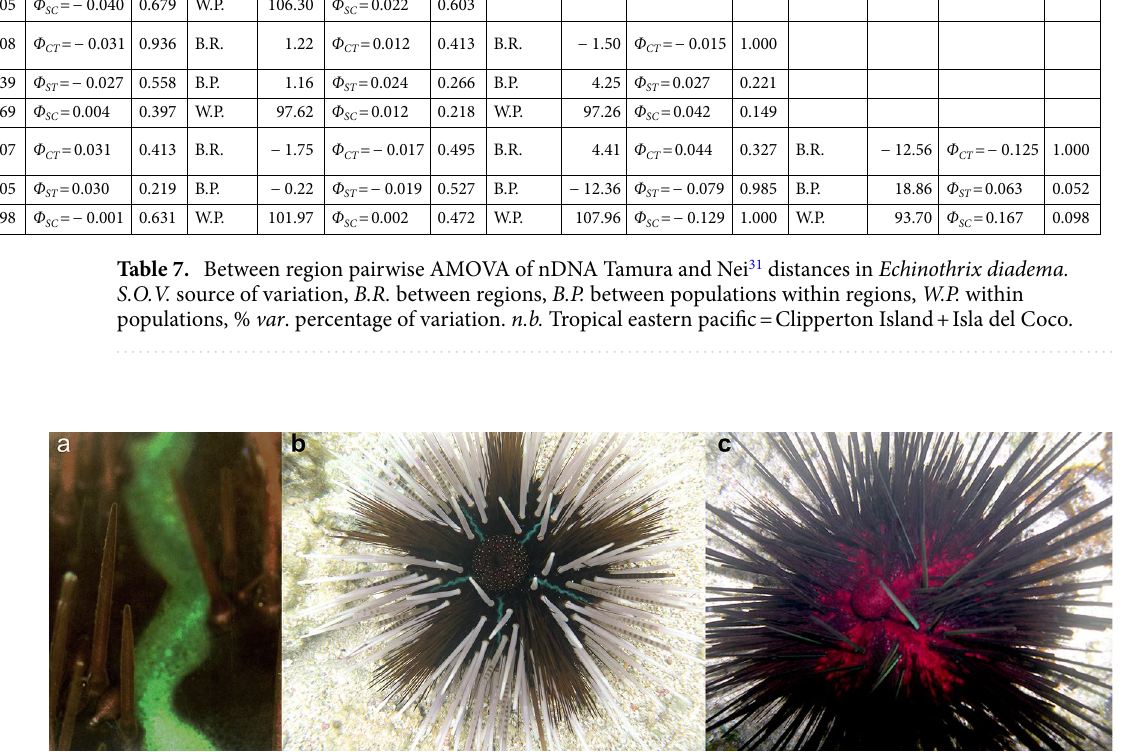
present only in E. calamaris, may advertise the venomous nature of the ambulacral spines 27,28 . However, these median regions were absent in some red and black colour morphs (Fig. 6c), as were white/yellow spots on the skin of the periproctal cone. At Sosoikula Reef, Suva, Fiji, five E. calamaris were members of clade 1, nineteen of clade 3, while a single specimen was a hybrid of E. diadema (nDNA) and E. calamaris mtDNA clade 3 (Fig. 1). The hybrid’s periproctal cone was black and small, resembling that of E. diadema . The spines around the edge of the interambulacra and down the entire ambulacra were banded black and grey, with a distinct blue/green sheen similar to E. diadema .